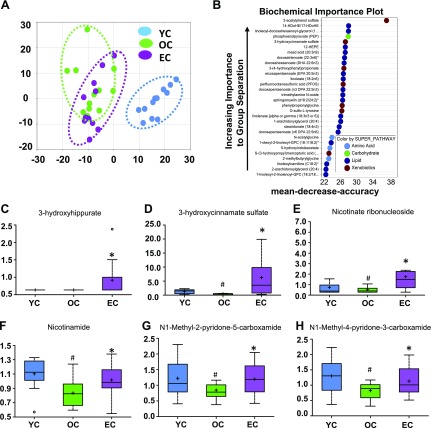
Dietary epicatechin reversed age-related metabolomic changes associated with NAD pathway in aged mice. Principal component analysis revealed perfect separation between YC and OC, and EC intake significantly shifted back to YC (A). Random forest analysis resulted in a predicted accuracy of 78% between groups (B), and levels of 6 metabolites were significantly changed by EC compared with the OC group (C–H). #P < 0.05 EC vs. YC; *P < 0.05 EC vs. OC (n = 12/group).